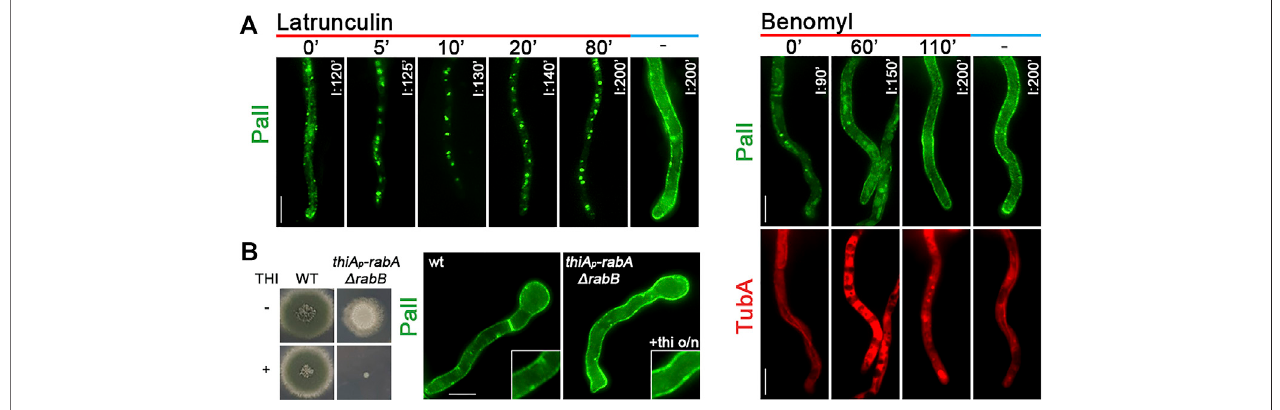
FIGURE 8 | Effect of actin or tubulin depolymerization in PalI subcellular localization. (A) Left panel : time course treatment with the actin depolymerization drug latrunculin B for 0, 5, 10, 20, or 80 min of a strain expressing neosynthesized PalI-GFP under conditions of derepression compared to an untreated strain included as control(200 min).LatrunculinBwasaddedat120 minofderepressionsothatthetotaltimeofPalI-GFPexpressionwas120,125,130,140,and200 mininthedifferent samples. The abolishment of sorting of PalI to the PM after 5 min of latrunculin B addition is noted in the growth medium. Right panel : time course treatment of strainsco-expressingneosynthesizedPalI-GFPandmCherry-TubAwiththeanti-microtubuledrugbenomyl,for0,60,or110 min.Inallcases,benomylwasaddedat90 of PalIderepression sothat thetotal time ofPalI-GFP expression was90, 150, or200 min. Benomyl abolished thethread-like appearance ofmicrotubulesin all samples added, evident by the diffuse cytoplasmic signal of mCherry-TubA. It is noted that PalI normally reaches the PM (best detected at 200 min of derepression). (B) When Rab5-dependent endosomes were knocked down/knocked out (i.e., in thiA p - rabA / Δ rabB ), fungal growth was arrested (as depicted in the growth test shown at the left panel); however, PalI-GFP was properly localized at the PM (right panel). Scale bars: 5 μ m.